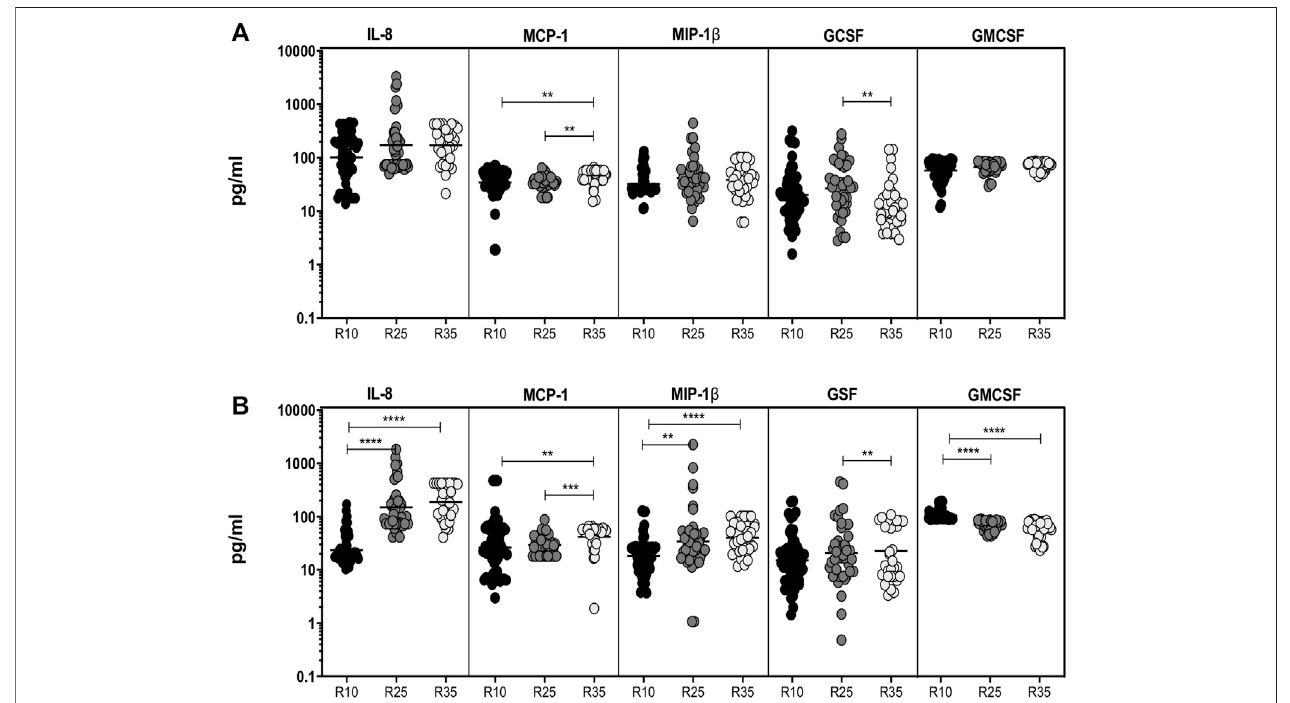
FIGURE 3 | High dose rifampicin is associated with altered chemokines and growth factors at second month in PTB individuals. (A) Baseline plasma levels of chemokines (IL-8, MCP-1, MIP-1 β ) and growth (GCSF, GMCSF) factors between the three different rifampicin (R10 [ n = 57], R25 [ n = 42], R35 [ n = 33]) treated arm of PTB individuals. (B) Second month plasma levels of chemokines (IL-8, MCP-1, MIP-1 β ) and growth (GCSF, GMCSF) factors between the three different rifampicin (R10[ n =57],R25[ n =42],R35[ n =33])treatedarmofPTBindividuals.WeusedKruskal – WallistestwithDunn ’ smultiplecomparisonstomeasurethe p valuesand each individual were denoted using scatter